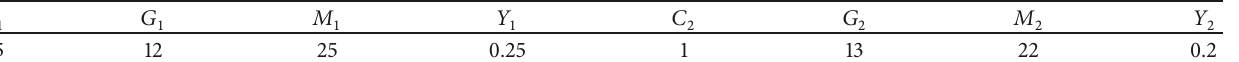
Table 4: parameter values of CGMY model.